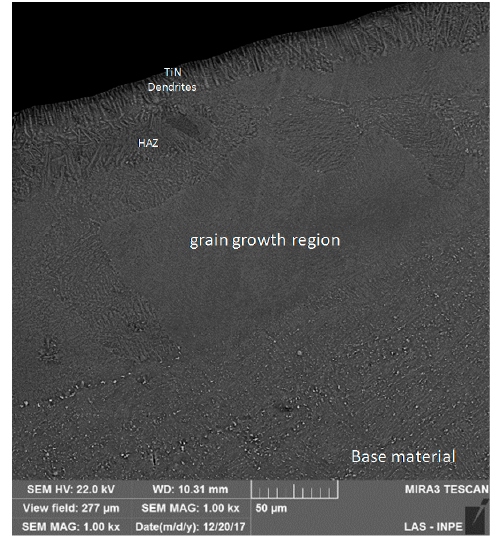
Figure 2. Longitudinal SEM of Widmanstätten microstructure after laser nitriding. Laser Power: 700 W.